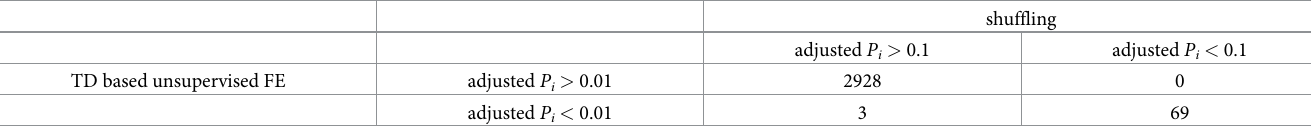
Table 7. Confusion matrix of selected mRNAs between TD-based unsupervised FE and shuffling in the first data set. P -value computed by Fisher’s exact test is 2.69 × 10 − 137 .